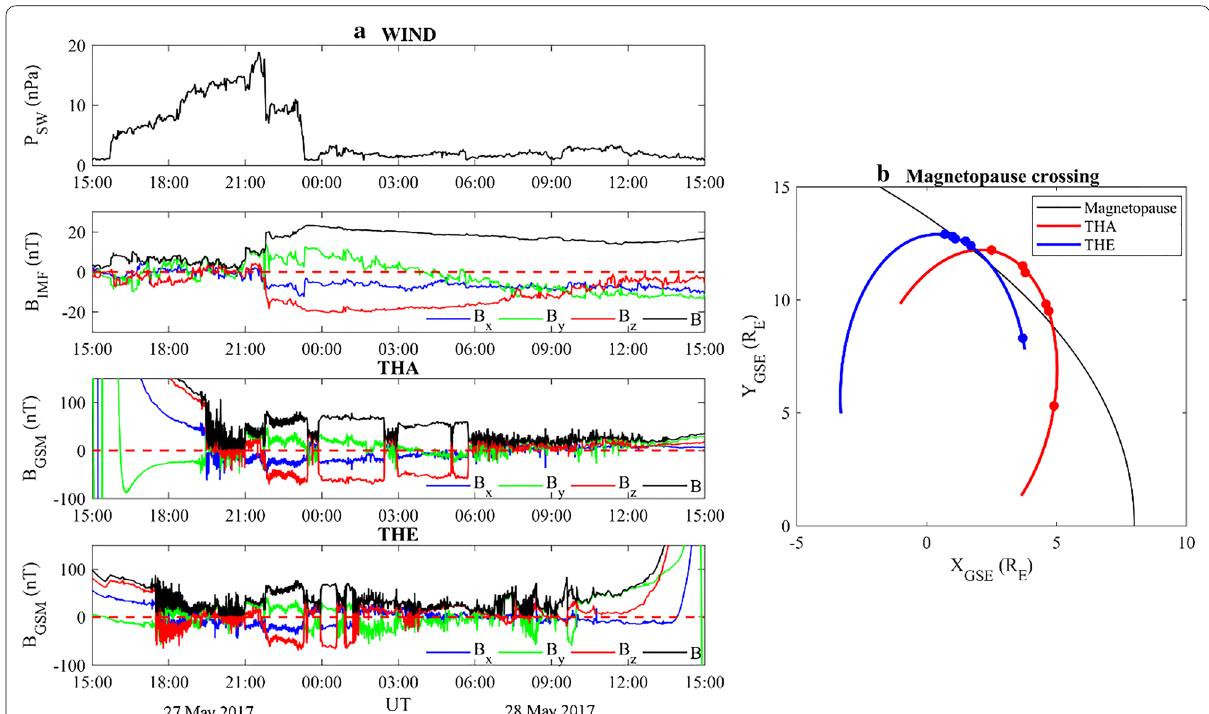
Fig. 6 a From the top: the dynamic pressure of the solar wind as measured by WIND, the strength and the three components of IMF at WIND and of the magnetospheric field at THEMIS A (THA) and THEMIS E (THE), from 15:00 UT on 27 May 2017 to 15:00 UT on 28 May 2017. b The black curve shows the Shue et al. (1998) magnetopause profile for P SW ~ 2 nPa and B z ,IMF ~ 18 nT. Red and blue curves show the trajectories of THA and THE − respectively, from ~ 17:00 UT on 27 May 2017 to ~ 13:00 UT on 28 May 2017 (full circles identify the magnetopause crossings)